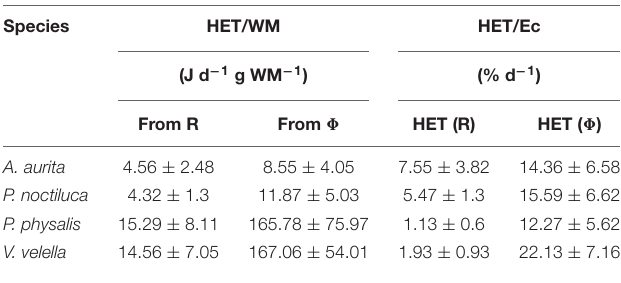
TABLE 4 | Compilation of the HET (mean ± SD) for our four species of planktonic cnidarians normalized by wet mass and by energy content (Ec).